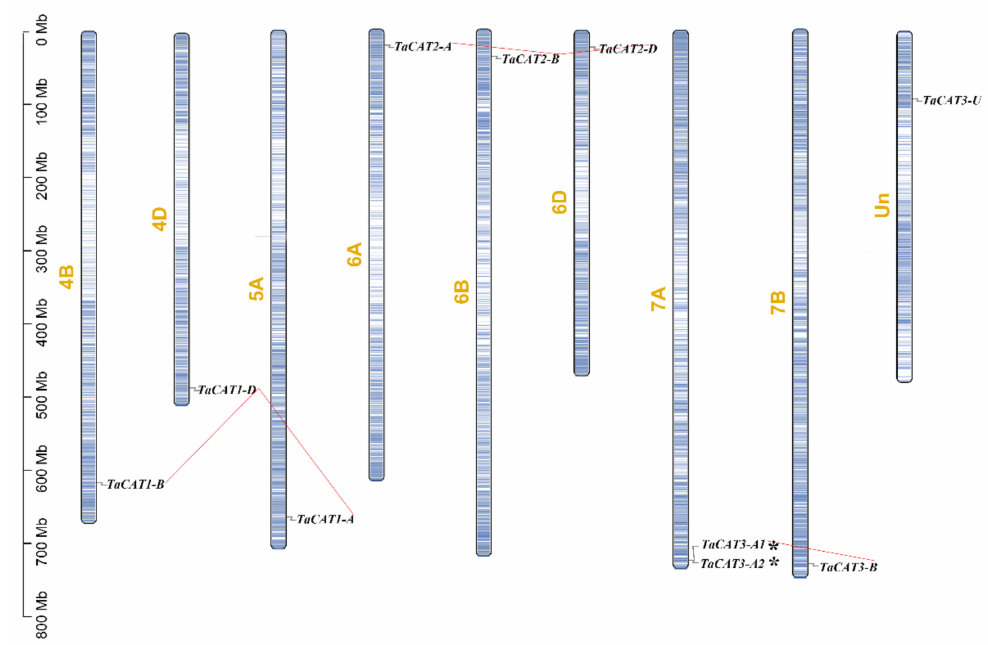
Figure 3. Schematic representations for chromosome distribution and duplication events of TaCAT genes. Chromosomal positions of Ten TaCAT genes were mapped on the basis of Wheat Genome (version IWGSC v1.0). Blue lines on each chromosome represented gene density. Segmental duplica- tion events were indicated by red lines. * indicated the tandem duplication TaCAT gene pair. Only chromosomes that containing TaCAT genes were represented, and the chromosome number was indicated next to each